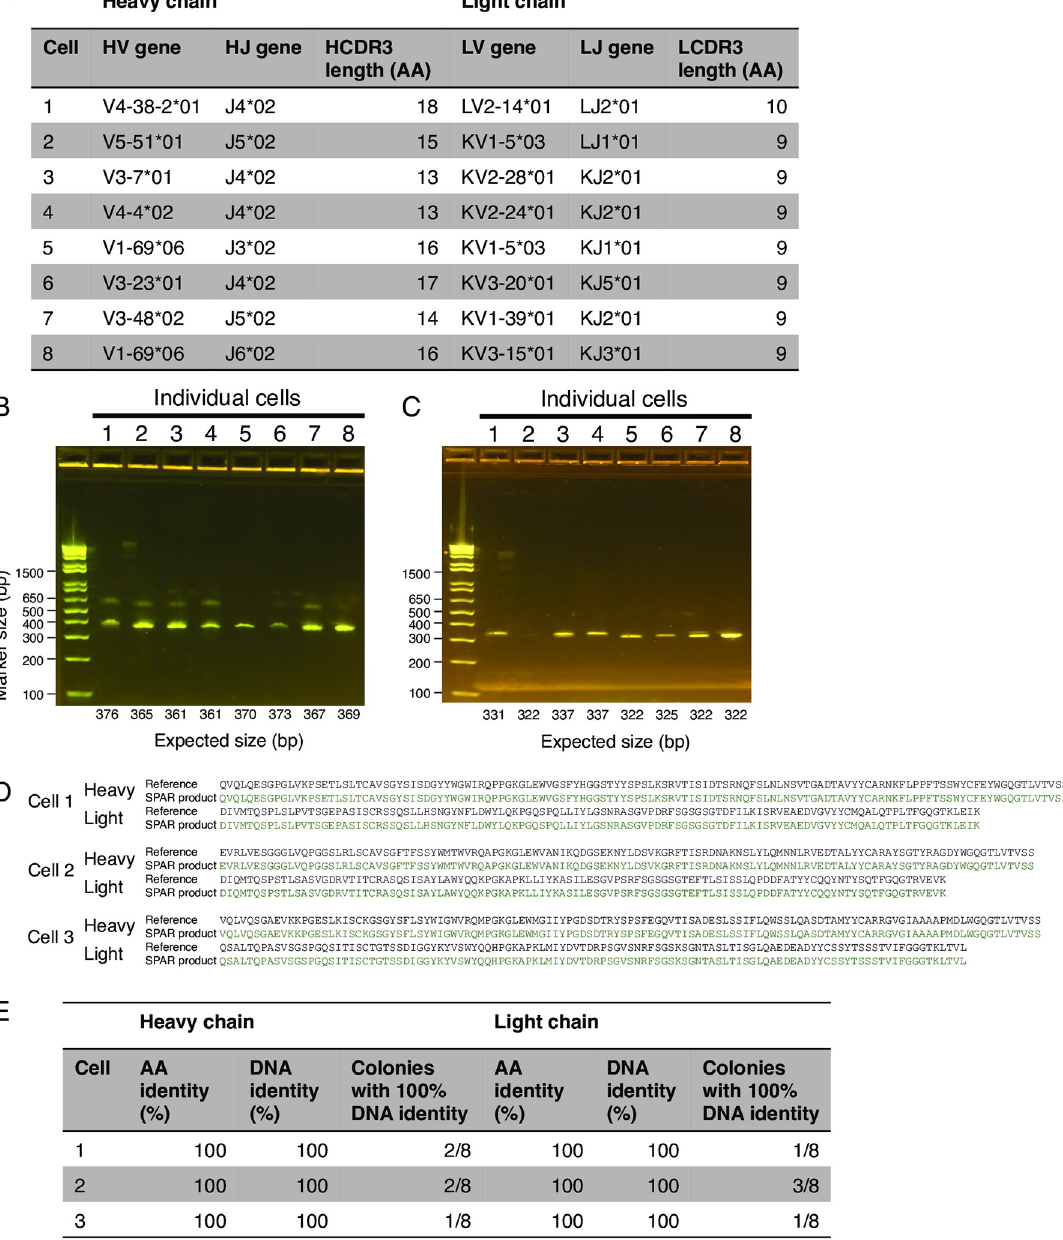
Fig 3. Retrieval of antibodies from single cells using SPAR. (A) Molecular features of antibodies targeted for retrieval originating from 8 single cells chosen at random from pooled sequence libraries. Heavy- and light-chain gene usage and CDR3 length are shown. HV, heavy-chain variable; HJ, heavy-chain joining; HCDR3, heavy-chain CDR3; LV, light-chain variable; LJ, light-chain joining; LCDR3, light-chain CDR3; AA, amino acids. (B and C) Agarose gel electrophoresis of SPAR PCR2 products (2% agarose) for heavy- (B) and light-chain genes (C). Expected size of each product is indicated by label at bottom. (D) Sequence verification of SPAR PCR2 products using Sanger sequencing for three cells. Heavy- and light-chain amino acid sequences of SPAR PCR2 products were aligned to the reference sequences obtained by single-cell sequencing. Residues matching the reference are shown in green. (E) Summary of SPAR products for three cells. Colonies were picked after transformation of Gibson Assembly products into E . coli , then constructs were Sanger sequenced. For each chain, the fraction of colonies with perfect (100%) identity to reference is shown. One colony with maximal identity to reference was chosen, and the amino acid (AA) and DNA identity of that colony to the reference is shown.